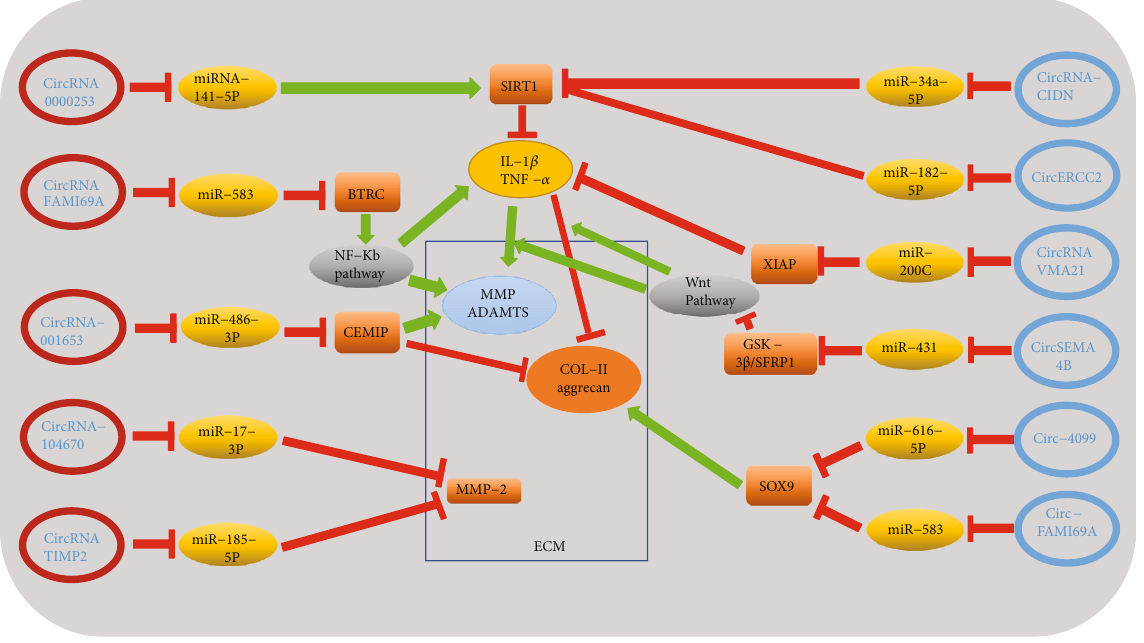
Figure 3: Red-labeled circRNA has a negative e ff ect on the metabolism of extracellular matrix and can promote the catabolism of ECM. However, blue-labeled circRNA plays a role in promoting the anabolism of ECM. Song et al. [73] suggested that circRNA_0000253 could promote IDD by adsorbing miRNA-141-5p and downregulating SIRT1. Guo et al. [44] revealed that circ-FAM169A promotes IDD development via the miR-583/BTRC signaling pathway. However, Li et al. [87] proved that circ-FAM169A promote NPC proliferation and extracellular matrix synthesis by the circ-FAM169A-miR-583 pathway. Cui and Zhang [88] suggested that circ_001653 inhibited ECM synthesis of NPCs in IDD by the miR-486-3p/CEMIP axis. Song et al. [89] proved that circRNA_104670 is upregulated in human IDD tissues and upregulates MMP-2 by directly sponging miR-17-3p. Guo et al. [90] revealed that circ-TIMP2 promoted dysmetabolism of ECM via the miR-185-5p-MMP2 pathway. Xiang et al. [91] revealed that circRNA-CIDN downregulated the expression of ECM catabolism enzymes (MMP-3 and MMP-13) and upregulated the level of anabolism markers (collagen II and aggrecan) by the miR-34a- 5p/SIRT1 pathway to retard compression-induced ECM degradation. Xie et al. [52] demonstrated that circERCC2 can mitigate ECM degradation via targeting miR-182-5p/SIRT1 axis. Cheng et al. [74] revealed that circVMA21 could alleviate in fl ammatory cytokine- induced dysmetabolism of ECM through the miR-200c-XIAP pathway. Wang et al. [92] demonstrated that circSEMA4B acts as a sponge and a ceRNA form miR431 in NPCs and competes with GSK-3 β and SFRP1 for miR-431 binding, thus inhibiting IL-1 β -induced degenerative process in NPCs through Wnt signaling. Wang et al. [84] revealed that circular RNA circ-4099 regulates ECM synthesis by blocking miR-616-5p inhibition of